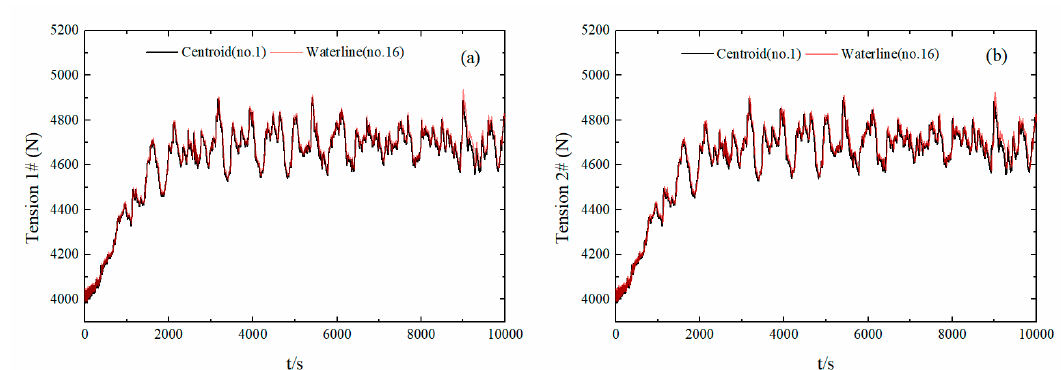
Figure 18. Anchor-chain tension time-history curves. (Sub-figures: ( a ) time-history curves of anchor chain I tension; ( b ) time-history curves of anchor chain II tension.).